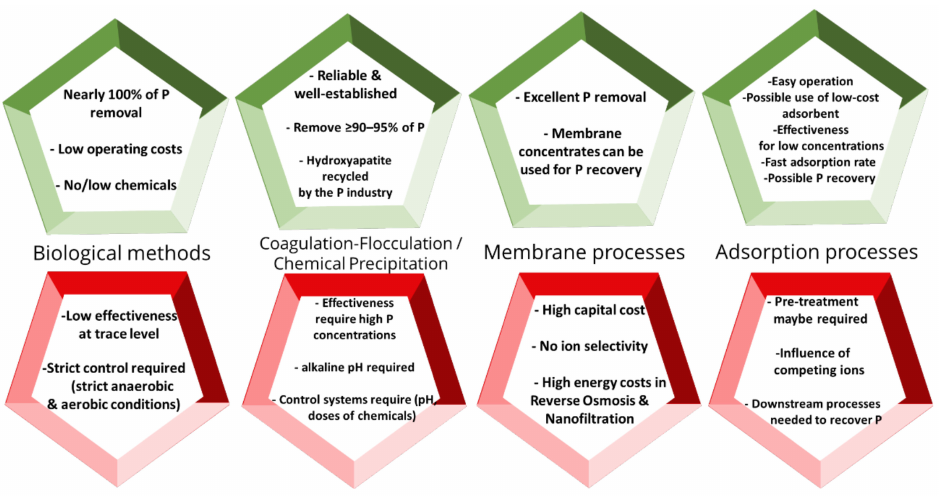
Figure 1. Synopsis of different approaches for P removal and recycling from wastewater (modified from